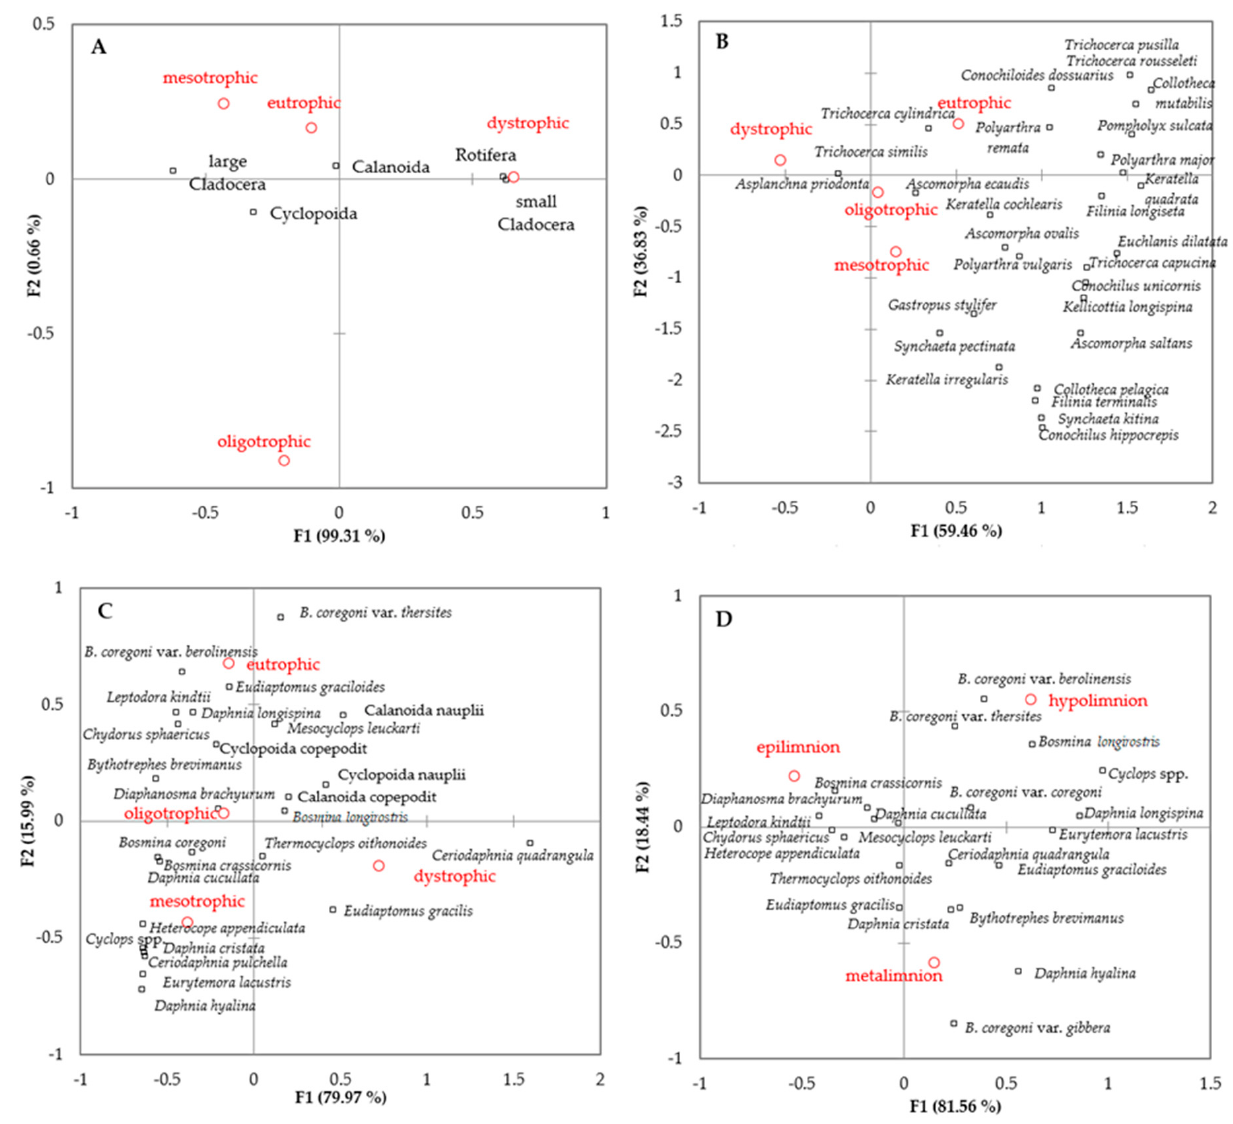
Figure 5. Zooplankton communities structure in different trophic conditions. Major zooplankton groups ( A ), Rotifera ( B ) and Crustacea ( C ) communities in different trophic conditions. The vertical distribution of crustacean zooplankton in clear lakes ( D ).